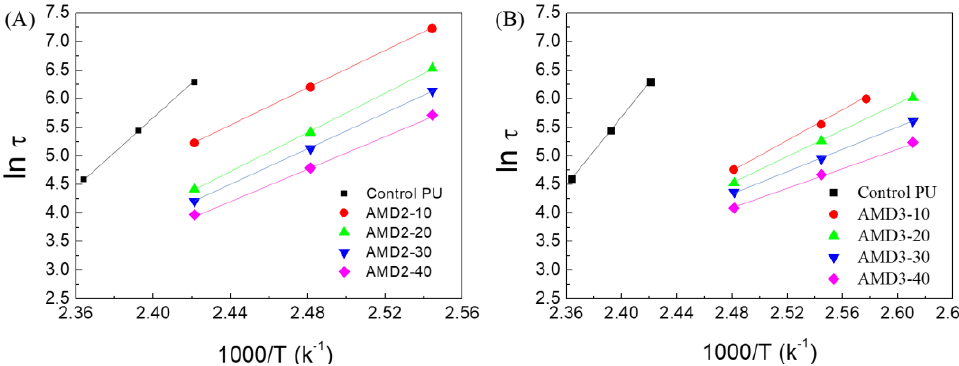
Figure 6. Arrhenius plots for relaxation times of AMD-based PUEs: ( A ) AMD2 based PUEs; and ( B ) AMD3 based PUEs.